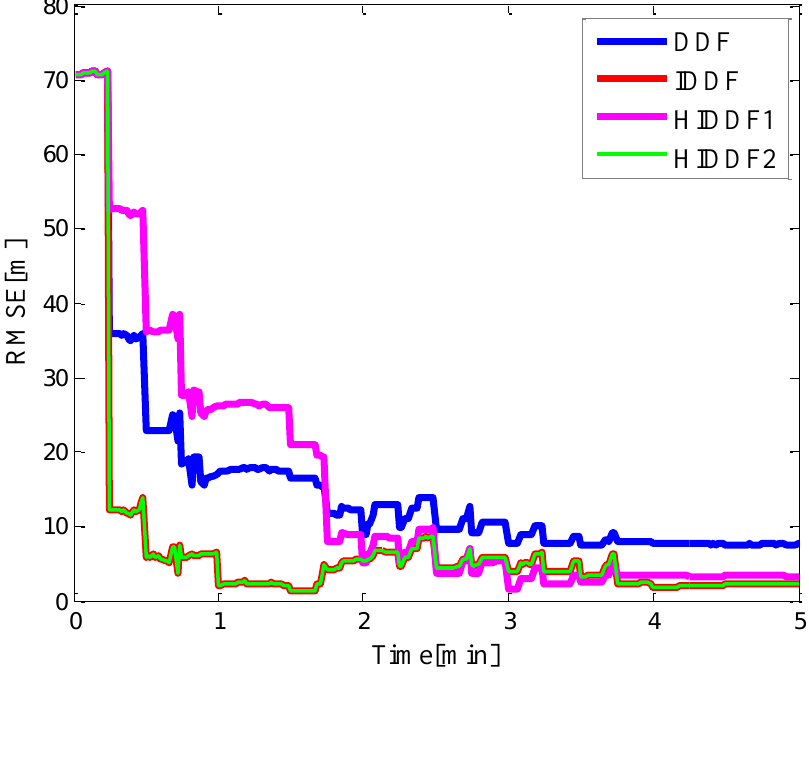
Figure 7. Comparison of convergence speed in large initial error; the HIDDF1 represents the HIDDF method with constant threshold value and the HIDDF2 represents the proposed HIDDF method with a variable threshold